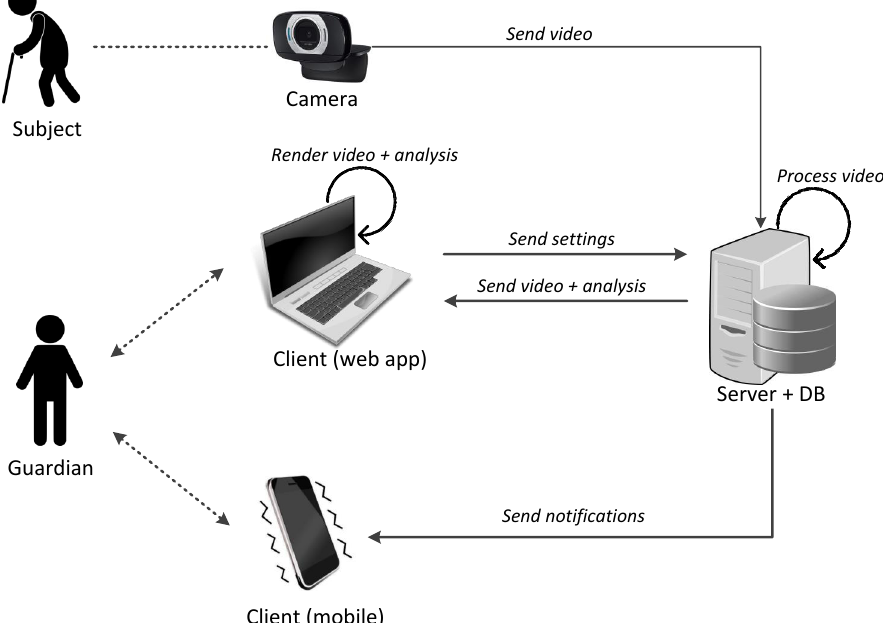
Figure 8. Architecture of our client-server application for assisted living